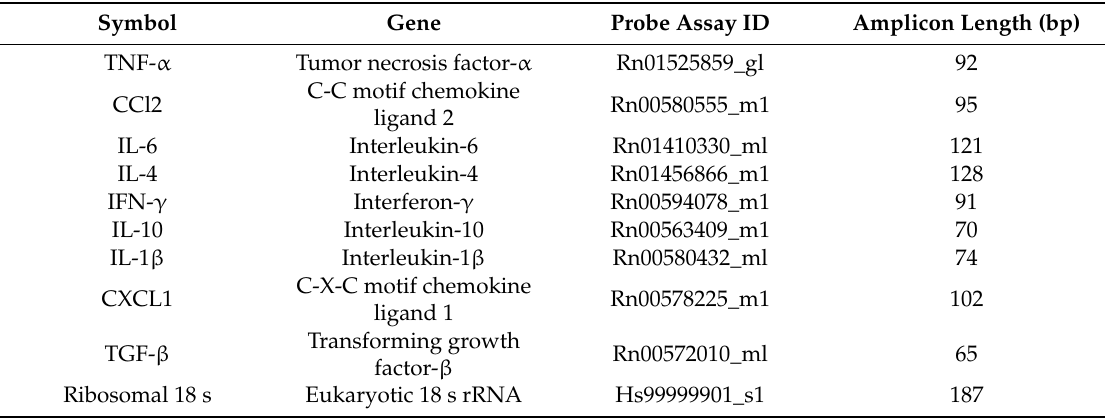
Table 2. The list of TaqMan probes used for real-time